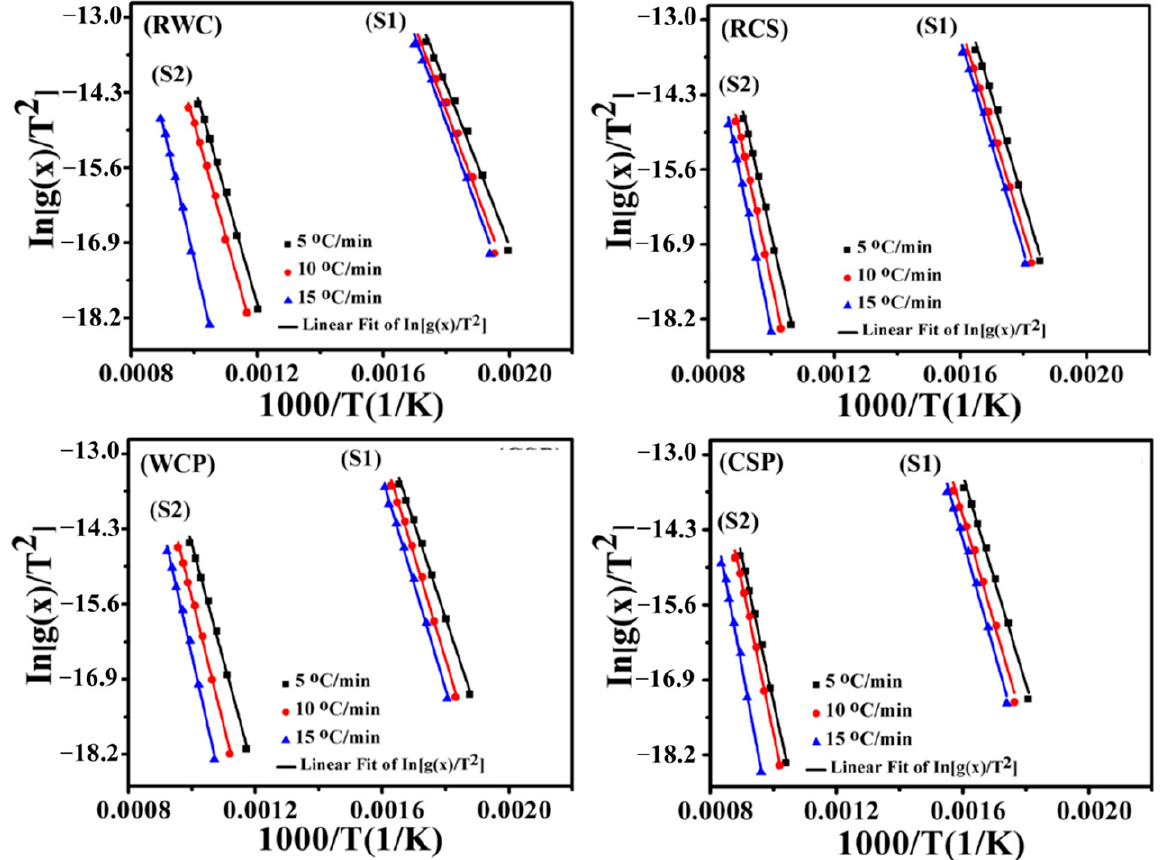
Figure 3. Plots of ln [g(x)/T 2 ] against 1/T. (S1: Stage 1, S2: Stage 2).